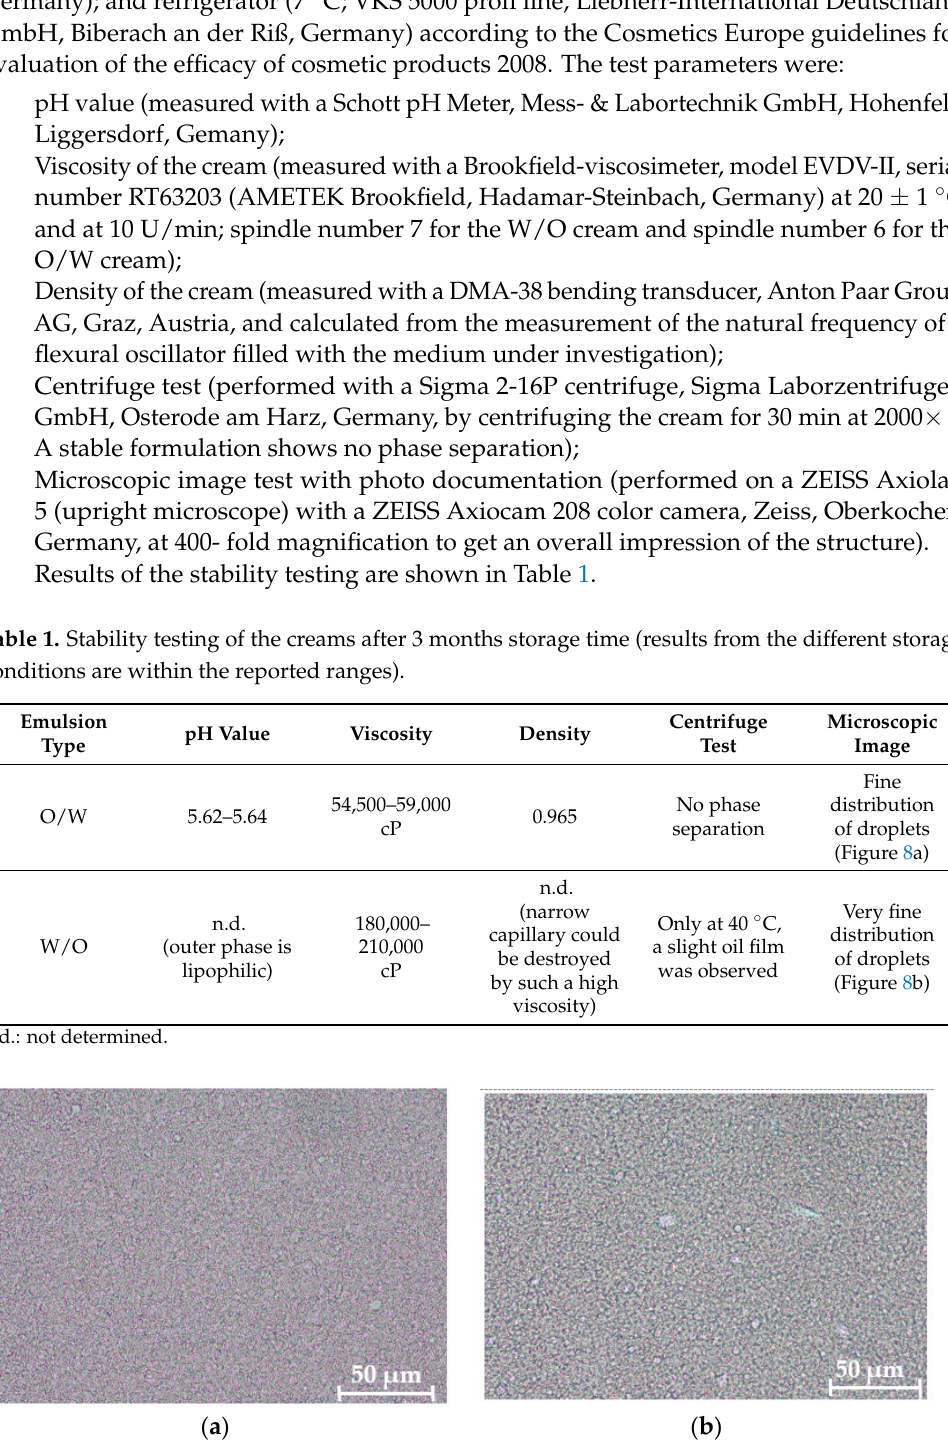
Table 1. Stability testing of the creams after 3 months storage time (results from the different storage conditions are within the reported ranges).